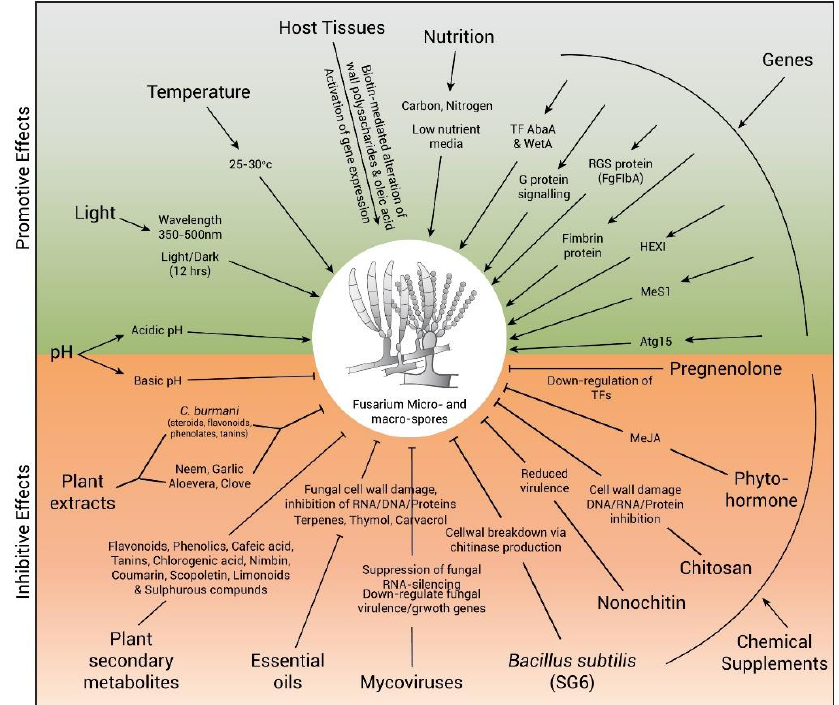
Figure 2. Factors affecting induction and inhibition of sporulation.